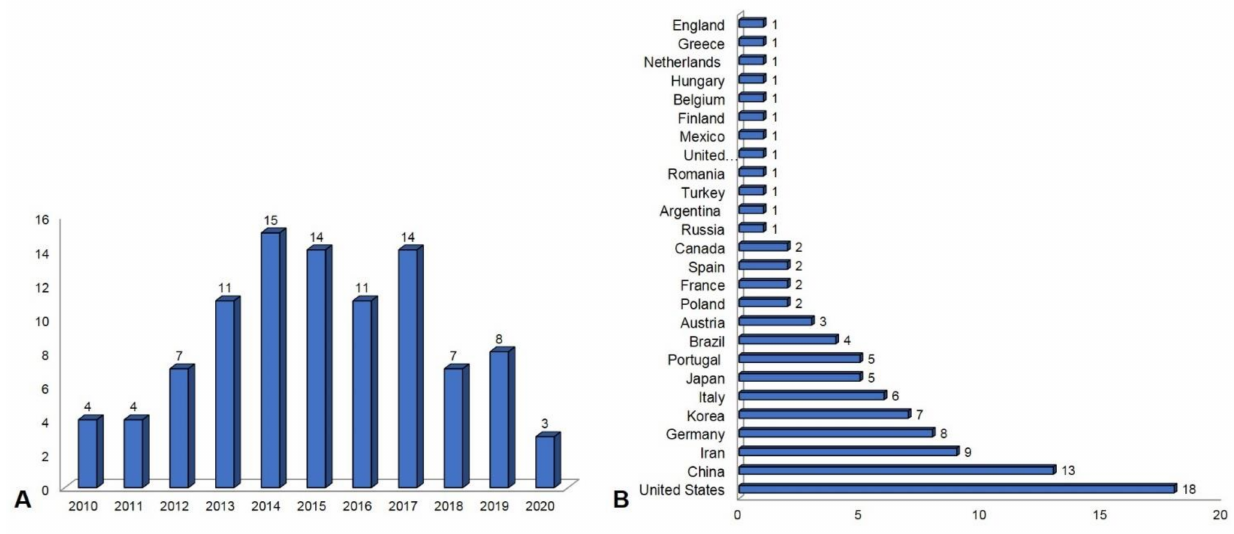
Figure 4. Overview of the numbers of publications about biomaterials and AD-MSCs for regenerative medicine worldwide. ( A ) Numbers of publications between 2010 and 2020. ( B ) Numbers of publication per